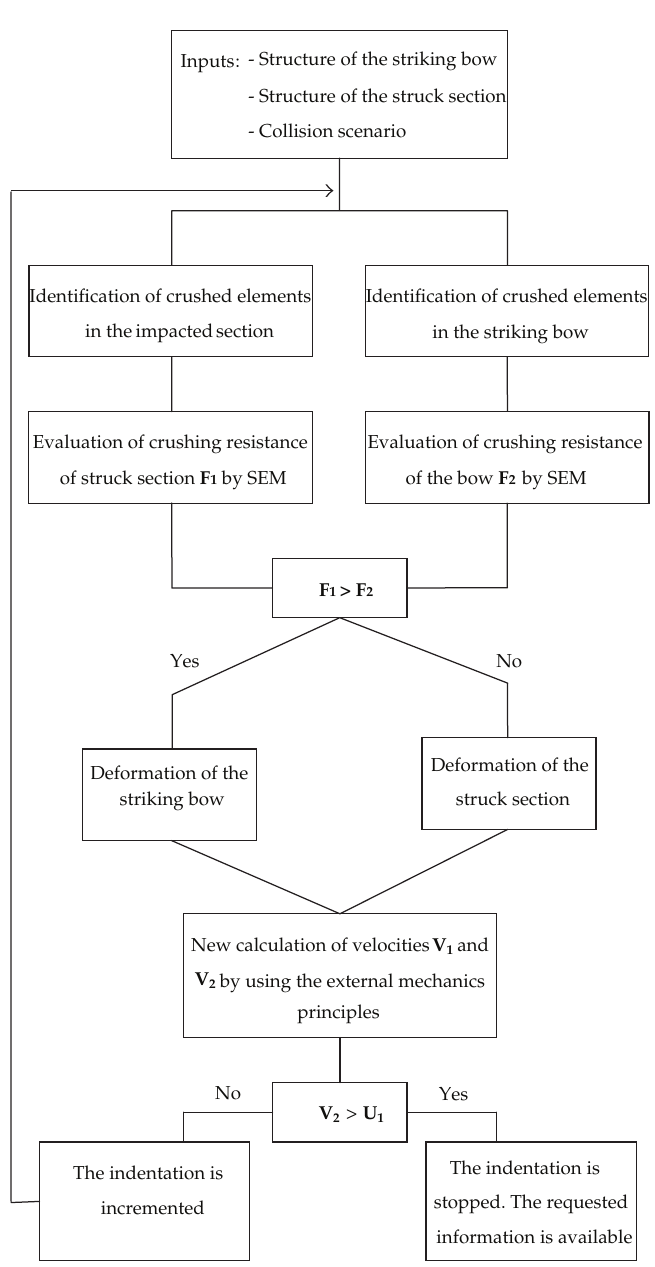
Figure 10: Flow chart of the collision analysis